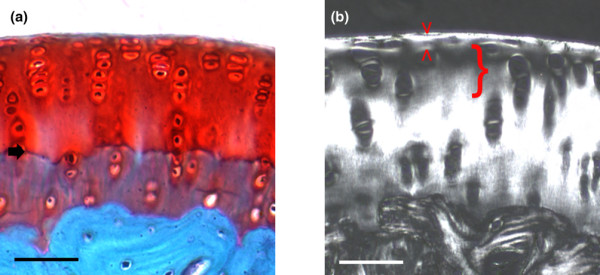
Microscopic images of joint cartilage from region of interest. (a) Rabbit MCP joint sections were stained with iron hematoxylin, safranin O, and fast green. This combination of stains identifies the uncalcified cartilage (red), calcified cartilage (dark red), and bone (blue-green). The tidemark (arrow) is apparent and marks the division between the uncalcified and calcified cartilage. (b) Unstained sections were imaged under polarized light microscopy. The superficial zone is indicated by the two arrows at the articular surface. The bracket encloses the mid zone, which due to the anisotropic arrangement of collagen fibers does not exhibit birefringence. Bars = 100 μm.